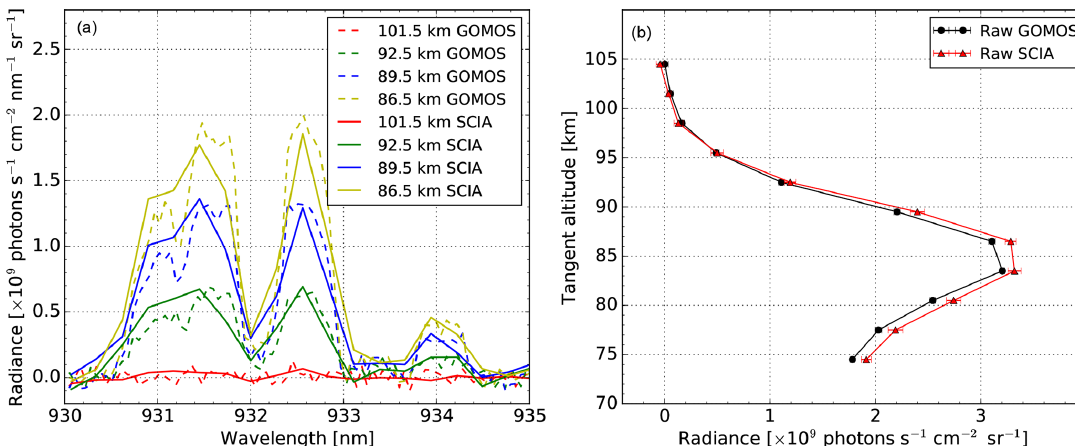
Figure 12. (a) SCIAMACHY (solid line) and GOMOS (dashed line) observations of monthly zonal mean OH(8–4) airglow emissions at the tangent altitudes, as given in the figure legend for April 2004 at 20–30 ◦ N and a local time of 22:00–00:00LT. (b) The spectrally integrated radiance over 930–935nm versus tangent altitude for the same conditions. The error bars are measurement noise, computed as in Fig. 4.